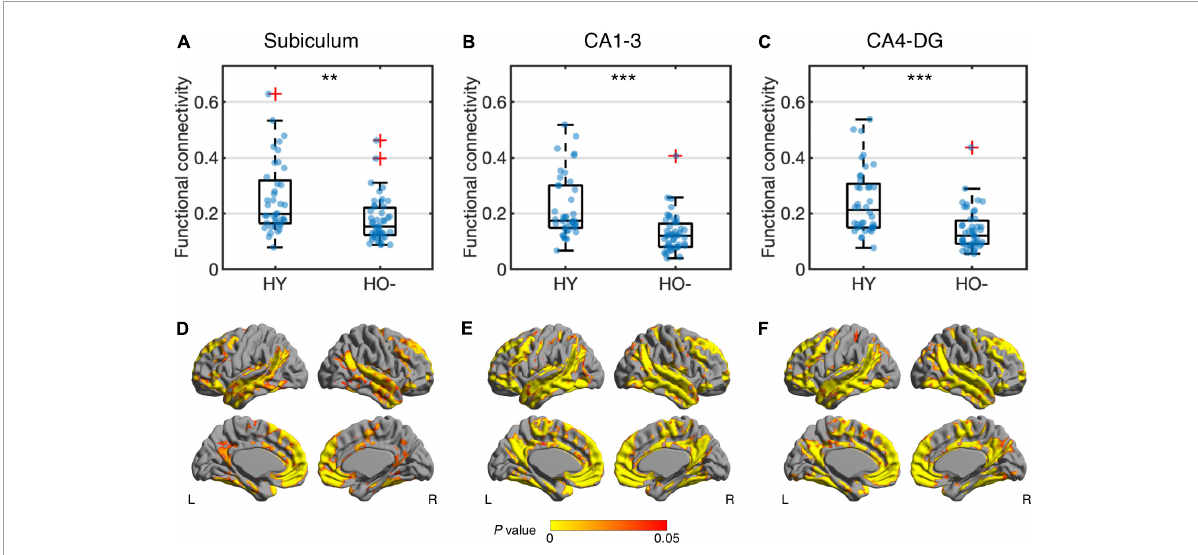
FIGURE3 Group differences of functional connectivity in the subiculum (A,D) , CA1-3 (B,E) and CA4-DG (C,F) networks between healthy young adults (HY) and healthy older adults with negative CSF biomarker status (HO − ). Box plots show the median, quartiles and whiskers that represent 1.5 × the interquartile range. P -values were determined using general linear models with sex, normalized whole hippocampal volume, and total intracranial volume as covariates, and adjusted for multiple comparisons using Holm-Bonferroni correction. In voxel-wise analysis (D–F) , the results were corrected using threshold-free cluster enhancement where family-wise error rate was controlled at 0.05. Significant at ** P < 0.01 and ***P <